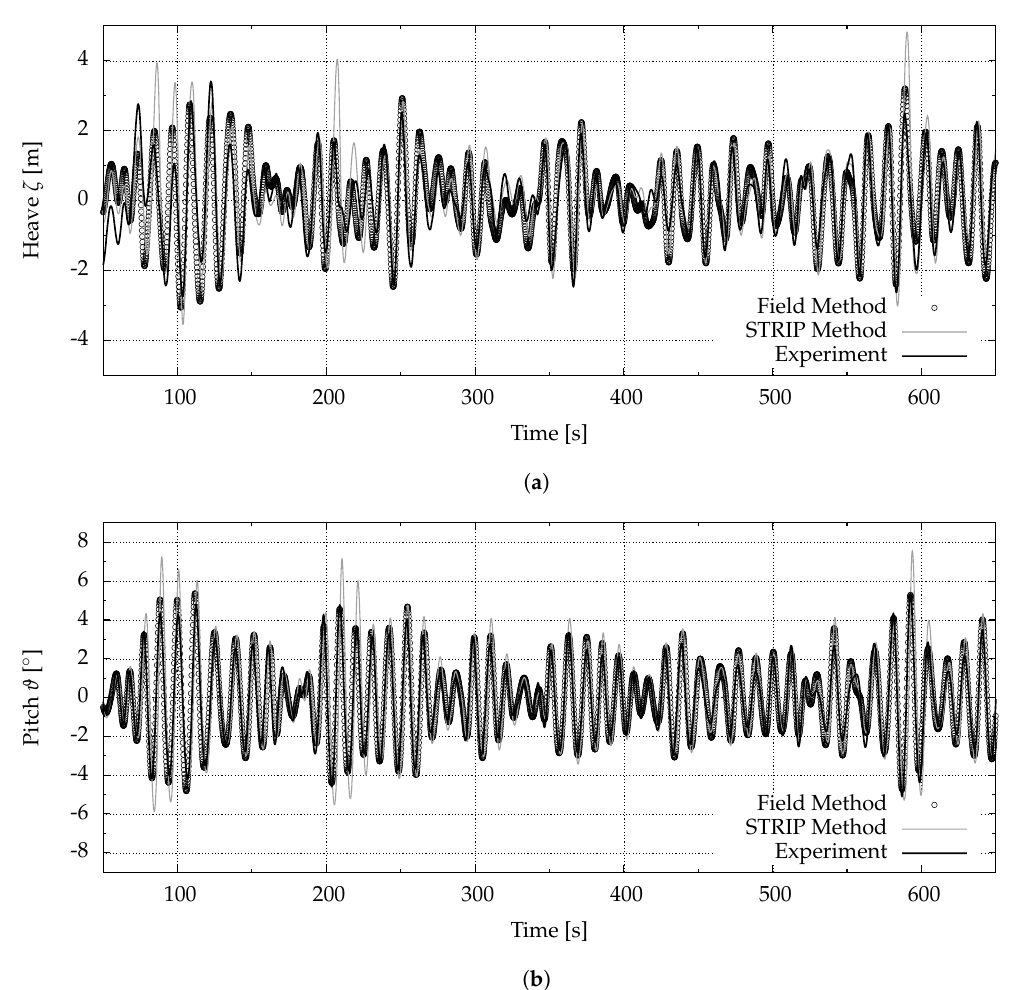
Figure 16. Cruise ship: comparison of time histories obtained with field method, strip method and experiments for ( a ) heave and ( b ) pitch